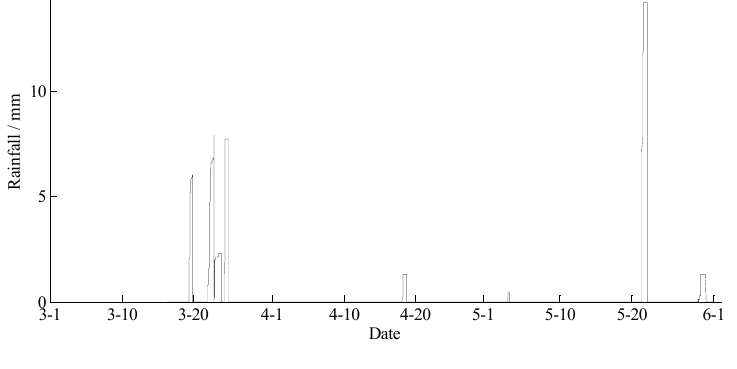
Figure 13. The curve of rainfall in Yan’er Ridge.